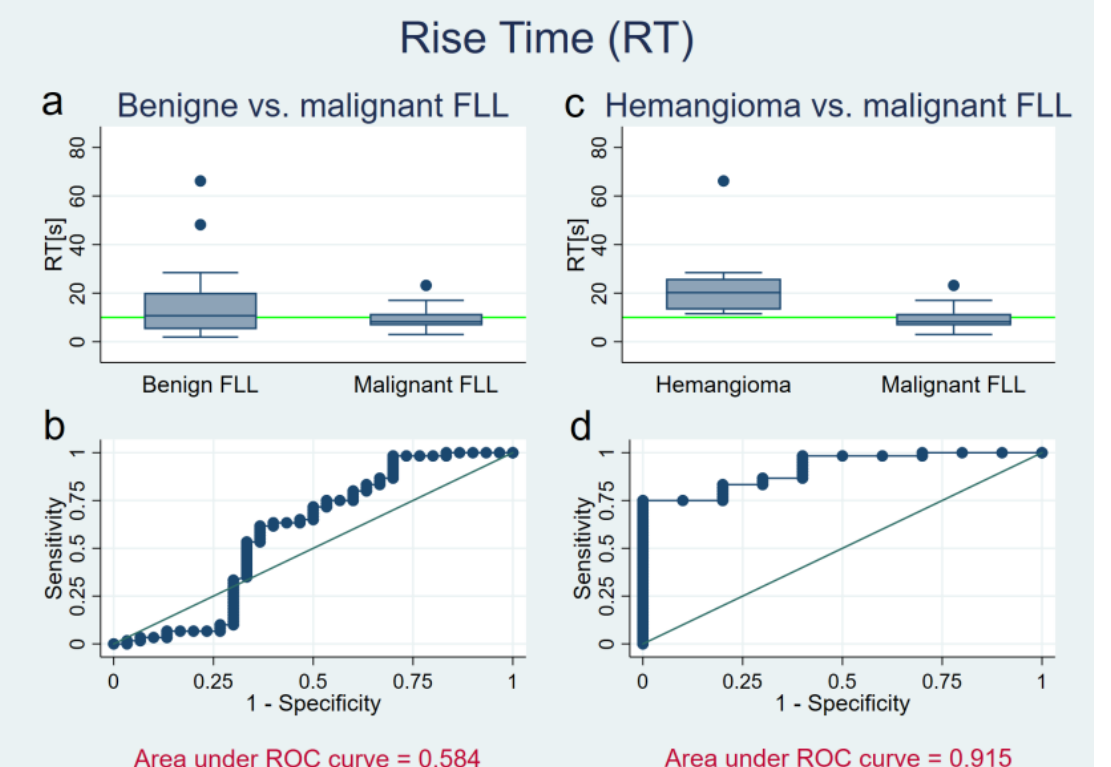
Figure 5. Rise time (RT) of benign liver lesions ( a , b ), and in a subgroup analysis of hemangiomas ( c , d ) versus malignant focal liver lesions (FLL). ( a , c ) The Y axis shows the RT of benign ( a ) FLL and hemangiomas ( c ) in comparison to malignant FLL. The green reference line is at 10 s. All hemangiomas lie over it, most malignancies lie beneath. Benign lesions present a wide spreading. ( b , d ) ROC curve of RT ( X axis: 1-Specifity; Y axis: Sensitivity) in discriminating malignant from benign liver lesions (Area under ROC curve = 0.584) ( b ) and malignant lesions from hemangiomas (Area under ROC curve = 0.915) ( d ).